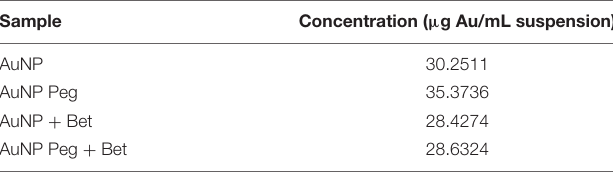
TABLE 1 | Gold concentration of nanogold samples determined by ICP-MS.